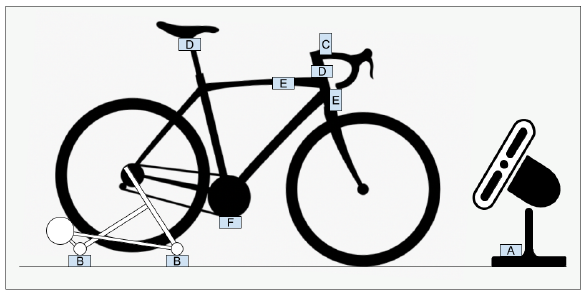
Figure1. SchematicimageofalldevicesincludedintheSimBikeSimulator: A) A fan used for wind feedback. B) Load cells used to estimate the user’s center of mass. C) A VR controller used to measure the handlebar’s forward direction. D) 1.5V electric motors that provide haptic feedback. E) Brake- measuring potentiometers. F) Mouse measuring the rotation of the central